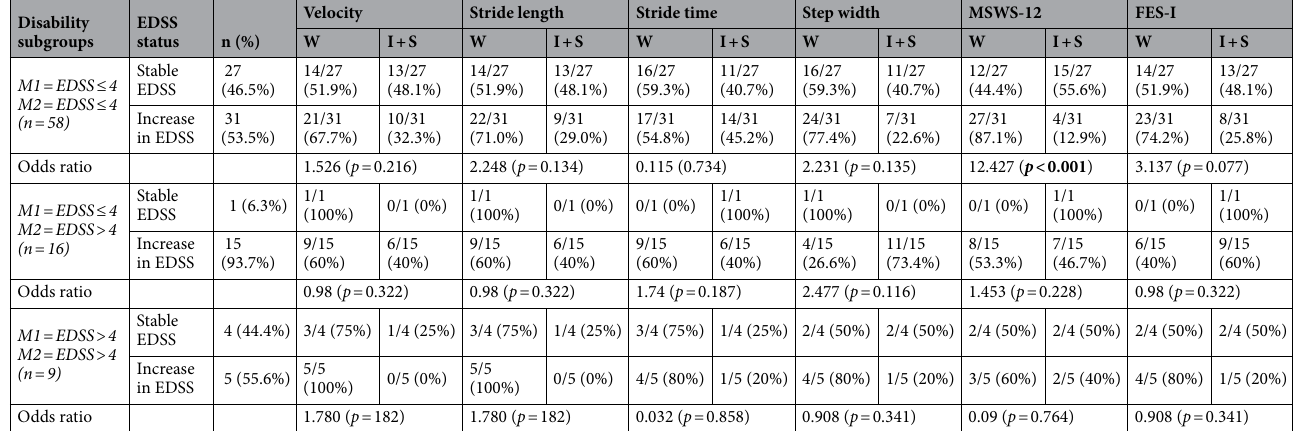
Table 4. Distribution according to disability subgroups, EDSS status at M2 compared with M1, and mobility performance at M2 compared with M1. Classification is based on condition at M2 compared with M1. Worsening is considered as any decrease in walking speed, shorter stride length, increased stride time, wider step width, more self-reported mobility difficulties (MSWS-12), and increased fear of falling (FES-I). W worsening, I improved, S similar. Significant values are in